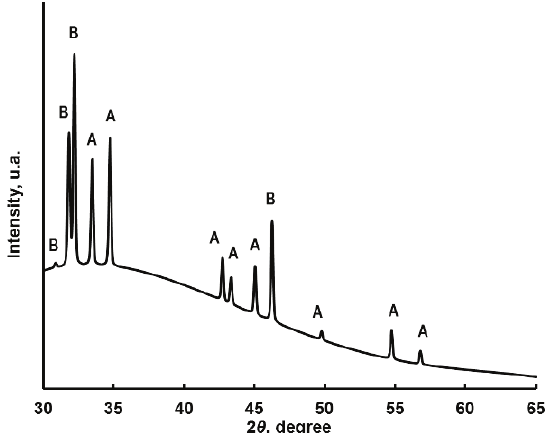
Figure 1. X−ray diffraction of polyamide fabric modified with Ag (A − Ag Se-24-1041, B – Se 2